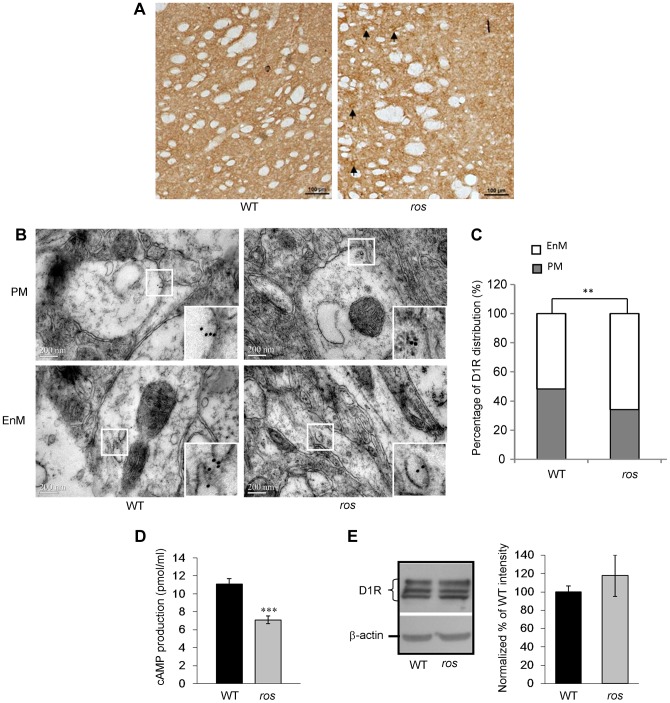
Plasma membrane D1R and its signaling are reduced in ros striatonigral neurons.Mice at 12 weeks of age were used in this study. (A) Immunohistochemical detection of D1R on the coronal brain sections of the striatum. In ros mice, visible immunoreactive cell bodies are present (arrows). Scale bar: 100 µm. (B, C) Representative immuno-EM pictures of D1R-labeled particles on plasma membrane (PM, upper panels) and endomembrane structures (EnM, lower panels) in wild-type (WT) and ros striatal neurons are shown without much difference (B). However, the quantification test revealed that the particles on PM in ros mice (34.0%, n = 103) is significantly lower than that in WT (51.7%, n = 87), **P<0.01. Scale bar: 200 nm. (D) SKF82958–induced cAMP accumulation in striatal membranes prepared from WT and ros mice. As compared with the WT (11.09±0.61 pmol/ml, n = 6), cAMP activity in ros membranes (7.11±0.45 pmol/ml, n = 6) was reduced about 36%. *P<0.001. (E) Immunoblot analysis of D1 receptor. left panel, Striatum tissues (20 µg) from WT and ros mice were probed with the monoclonal D1R antibody. β-actin was used as a loading control. The immunoblots shown are representative of three independent experiments. right panel, Normalized percentages of the band intensities shown in left panel are means ± SEM (n = 3). There is no significant difference of total D1R levels between WT and ros mice (P>0.05).